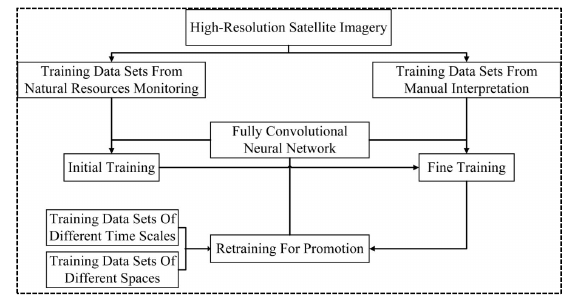
Figure2. Three training processes based on Convolutional Neural Network for grain crops monitoring